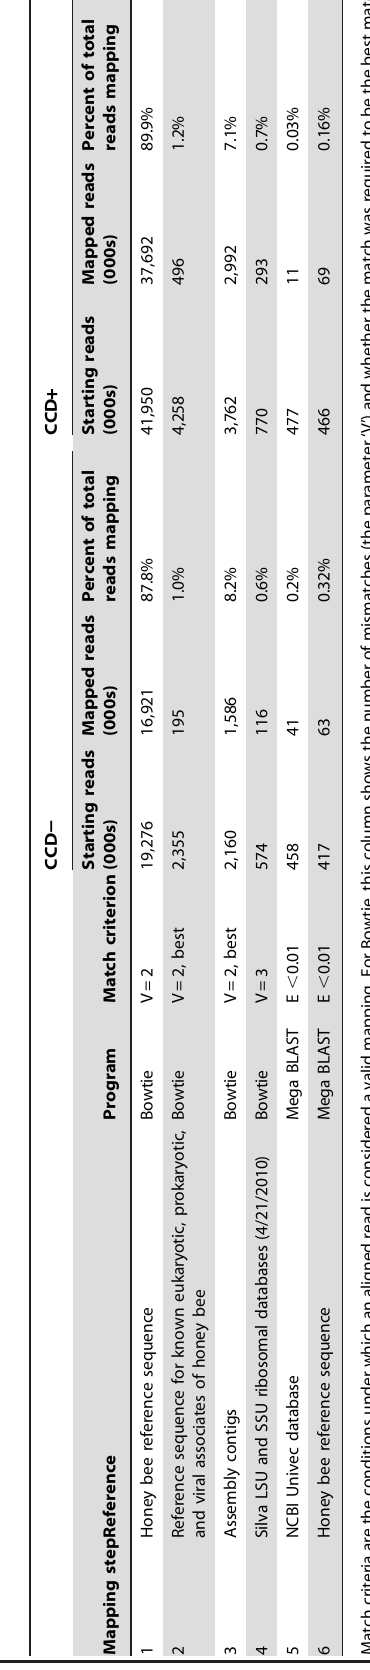
Table 4. Pearson correlation coefficients of pathogen abundance within randomly sampled individual worker bees from colonies with an observable Nosema infection but no characteristics of CCD.